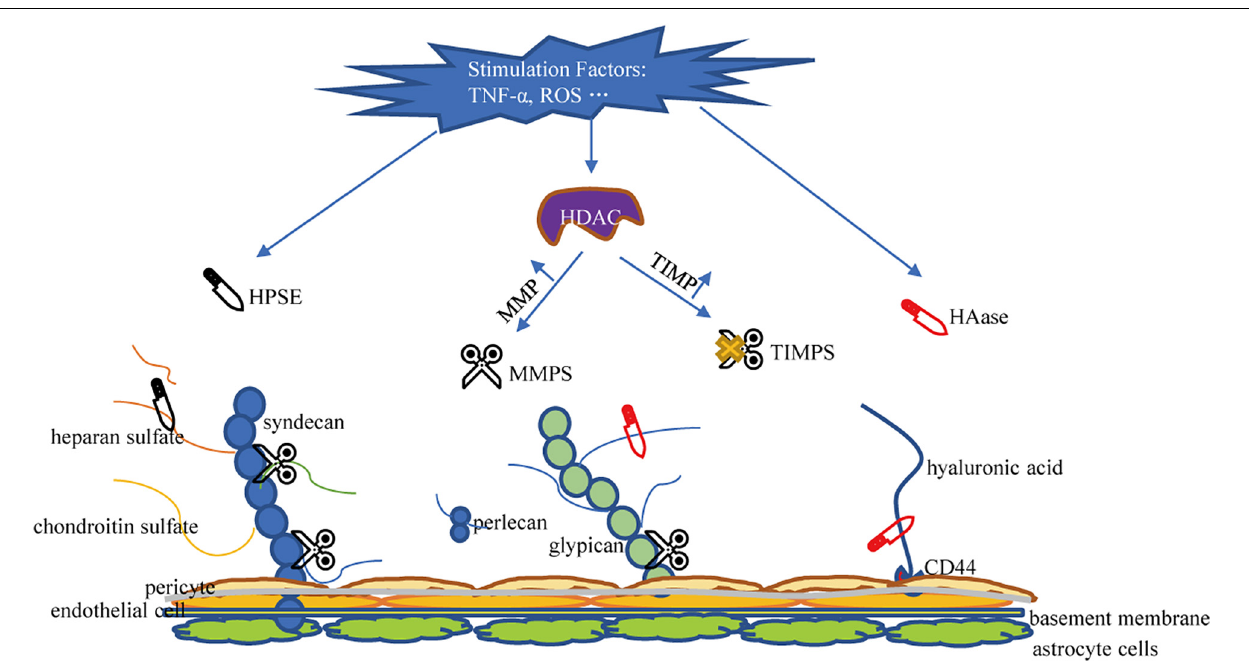
FIGURE 3 | Mechanisms of glycocalyx damage. HPSE, Heparanase; HAase, hyaluronidase; MMPS, matrix metalloproteinases; TIMPS, tissue inhibitor of matrix metalloproteinases; HDAC, histone deacetylase; HA, hyaluronic acid; HS, heparan sulfate; CS, chondroitin sulfate.